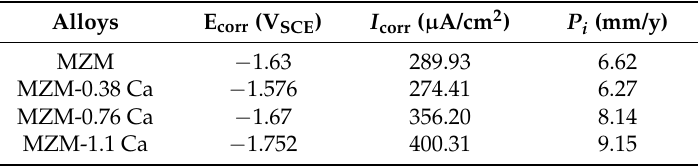
Figure 5. Electrochemical behaviors of MZM-xCa alloys in a simulated body fluid: ( a ) polarization curves; ( b ) nyquist plots; ( c ) bode plots of |Z| vs. frequency; and ( d ) bode plots of phase angle vs. frequency. Table 3. Result of the electrochemical polarization tests in SBF solution.